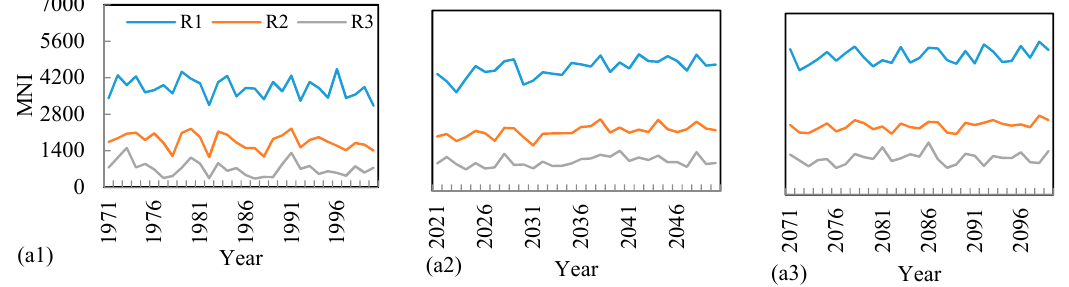
Figure 8. Mean MNI of fire season for three vegetation zones in different period. (a1) mean MNI of fire season in baseline; (a2) mean MNI of fire season in 2030s; (a3) mean MNI of fire season in 2080s.